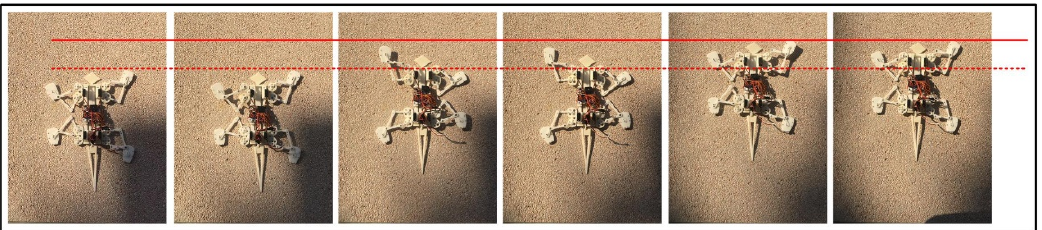
Figure 11. Experiment of the locomotion of the bionic robot climbing on the cloth surface in cycle.